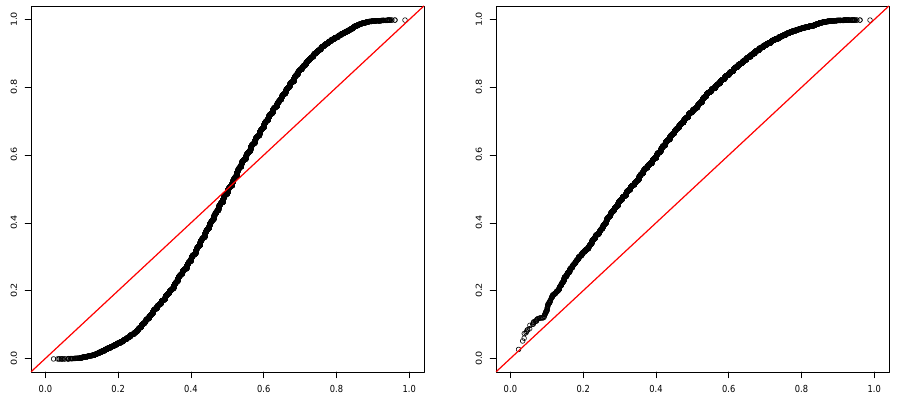
Figure 13. Comparison of asymptotic and bootstrap p -values under the null hypothesis and binomial innovations: ( left panel ) semiparametric bootstrap; ( right panel ) parametric bootstrap. The red dashed line represents the 45-degree